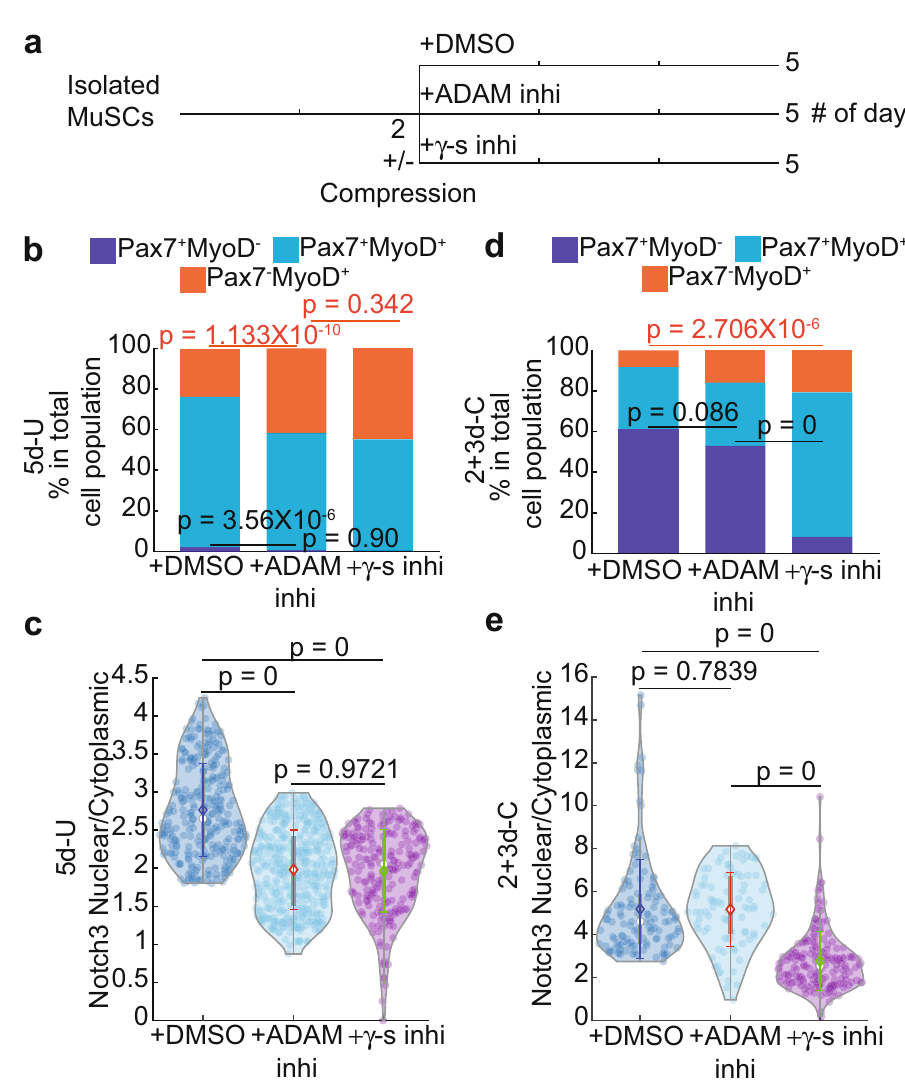
Fig. 4 Notch nuclear enrichment assay and cell fate evaluation after blocking S2 ( + ADAM inhi) or S3 ( + γ -s inhi). a Experimental setup. b and c 5d-U cells ’ fate ( b ) and Notch3 nuclear/cytoplasmic ratio ( c ) comparison after between control ( + DMSO) and blocking S2 or S3 cleavage ( b n = 7 for + DMSO, of total 1303 cells; n = 3 for + ADAM inhi, of total 332 cells; n = 3 for + γ -s inhi, of total 596 cells. c + DMSO data is same as in Fig. 3j. n = 4 for + ADAM inhi, of total 423 cells. n = 3 for + γ -s inhi, of total 215 cells). d and e 2 + 3d-C cells ’ fate ( d ) and Notch3 nuclear/cytoplasmic ratio ( e ) comparison between control ( + DMSO) and blocking S2 or S3 cleavage ( d n = 7 for + DMSO, of total 280 cells; n = 5 for + ADAM inhi, of total 183 cells; n = 4 for + γ -s inhi: of total 715 cells. ( e ) + DMSO data is the same as in Fig. 3j. n = 3 for + ADAM inhi, of total 88 cells. n = 3 for + γ -s inhi, of total 169 cells). Data in b and d was presented with an overall fraction. p -value was assessed based on a two-tailed Cochran – Mantel – Haenszel test using MATLAB. ( c ) and ( e ) data was presented with mean ± s.d. p -value was assessed with Kruskal – Wallis tests using MATLAB. The comparison was considered signi fi cant if p (cid:1) 0 : 05. Representative images are shown in Supplementary Fig. 8c –